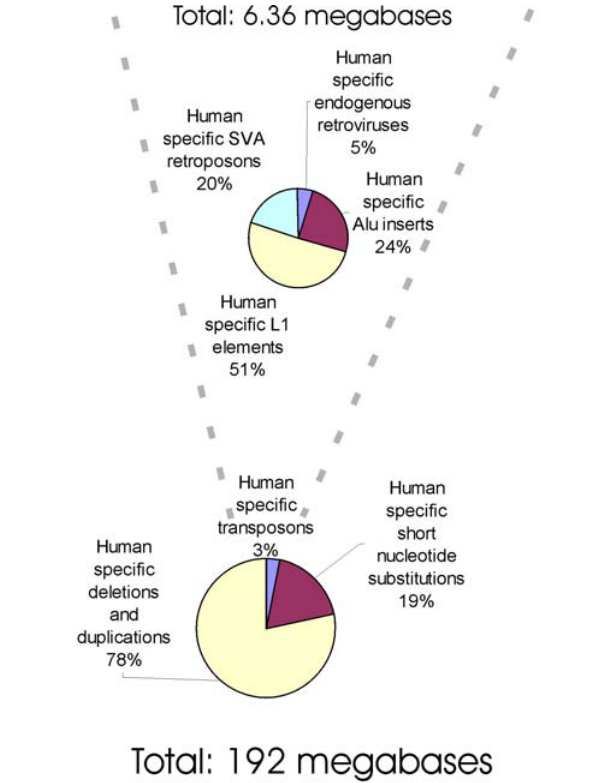
FIGURE 1. Endogenous retroviruses occupy ~5% of the DNA shaped by human-specific transposable elements, which, in turn, form only 3% of the total lineage-specific